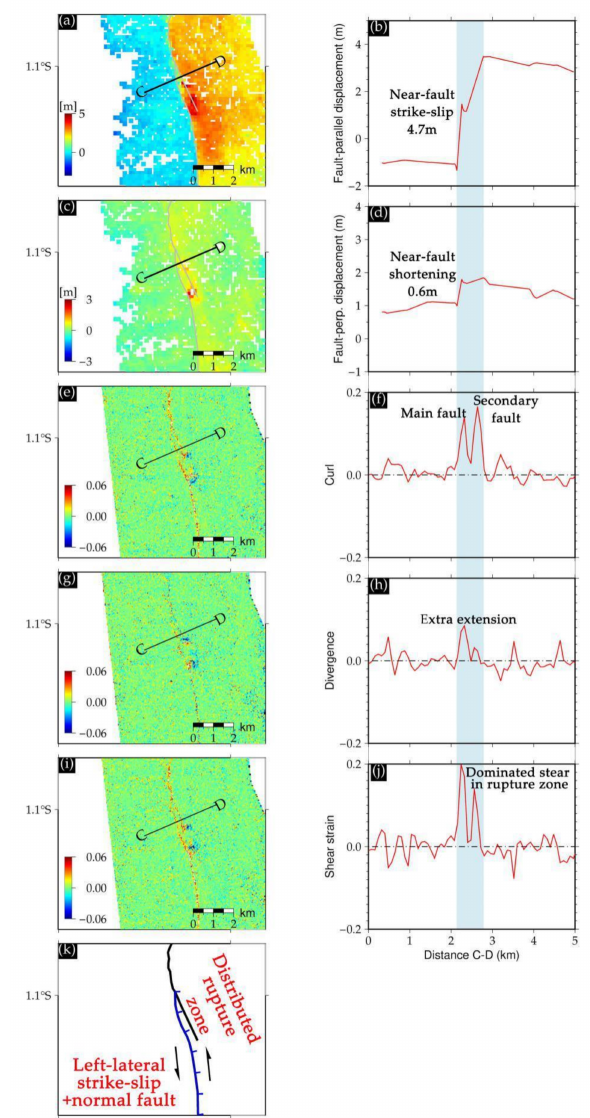
Figure 6. Deformation pattern showing a distributed rupture zone. ( a ) Fault-parallel displacement field; ( b ) across-fault fault-parallel displacement along profile CD; ( c ) fault-perpendicular displacement field; ( d ) across-fault fault-perpendicular displacement along profile CD; ( e ) curl field; ( f ) curl along profile CD, where two peaks at the rupture correspond to the main and secondary faults; ( g ) divergence field; ( h ) divergence along profile CD, where maximum divergence at the main rupture is positive, indicatingextraextension; ( i )shearstrainfield; ( j )shearstrainalongprofileCD,whereshearstrainvalues in the distributed rupture zone are positive, indicating rupturing under predominately left-lateral shear strain; ( k ) characteristics and geometric variation controlling the distributed rupture zone. The blue stripe denotes the distributed rupture